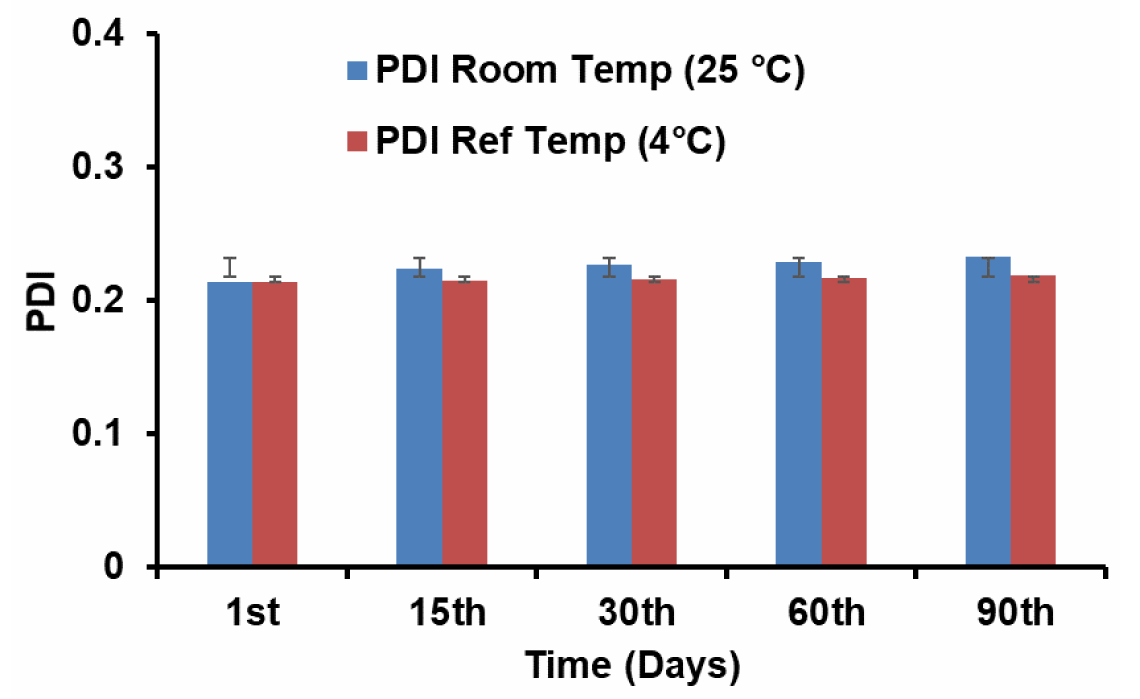
Figure 8. PDI of NOR-5 as a function of time. Ref; Refrigerated.